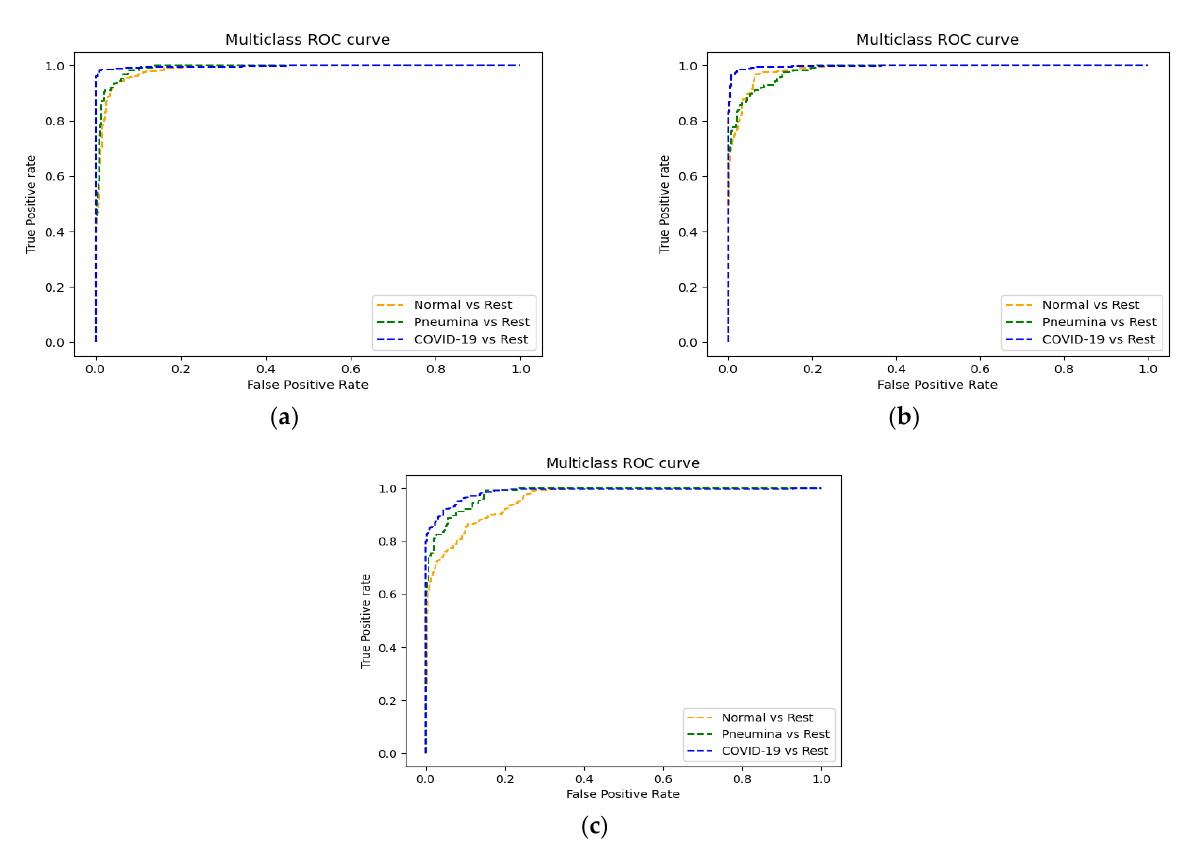
Figure 7. ROC curves of the three models: ( a ) EfficientNet-B2, ( b ) ViT, and ( c ) gMLP. We show the one-vs-rest ROC curve for the three